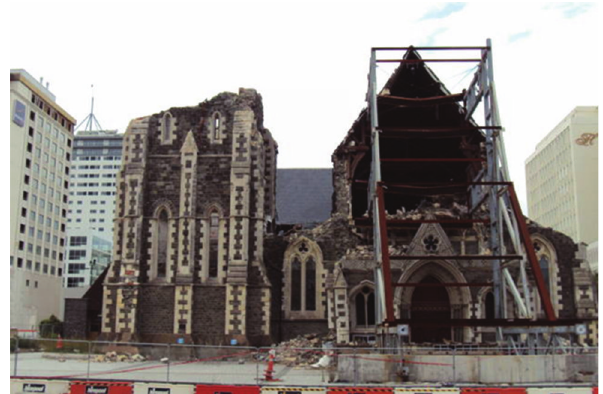
Figure 1: The Christchurch cathedral after the February 22, 2011 magnitude 6.3